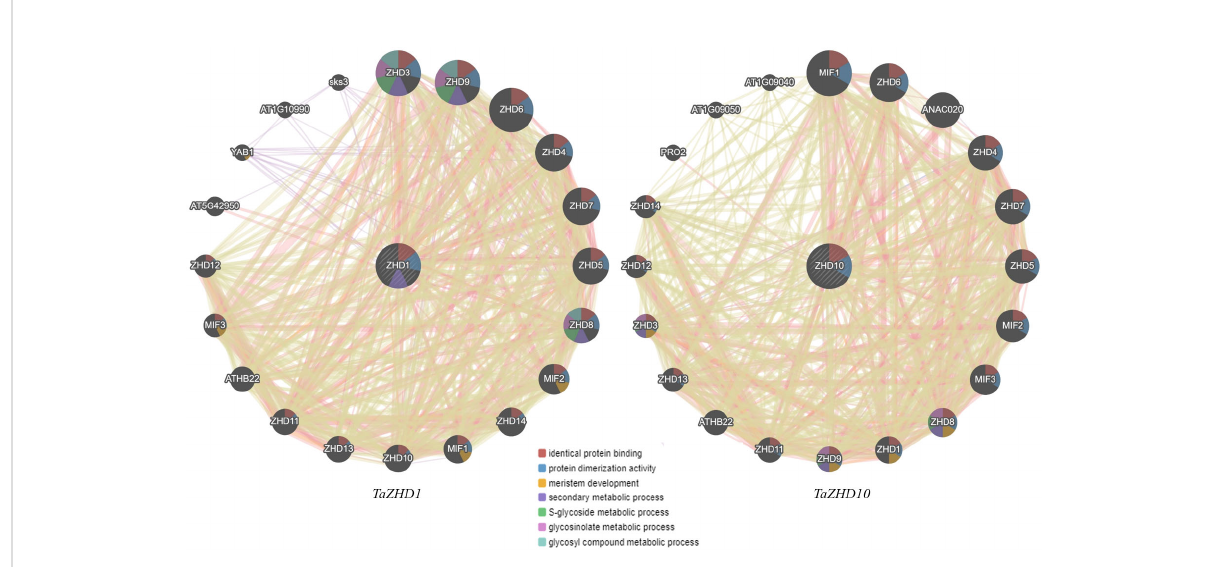
FIGURE 9 Gene interaction network of candidate leaf rolling ZHD genes with their regulatory partners taking A. thaliana as